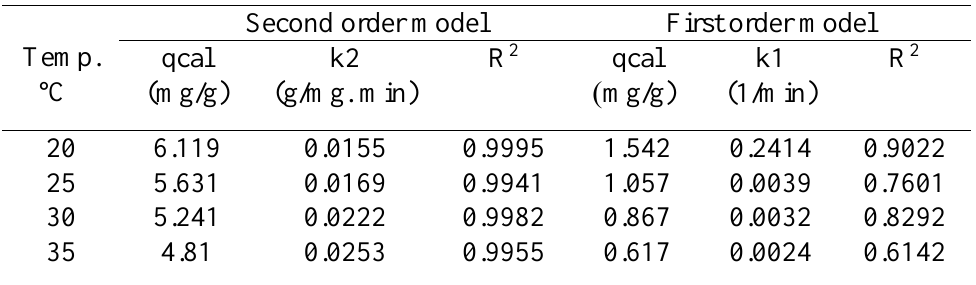
Table 2. Average value of kinetic parameter of the adsorption process in methylene blue at temperatures ( 20, 25, 30, 35)